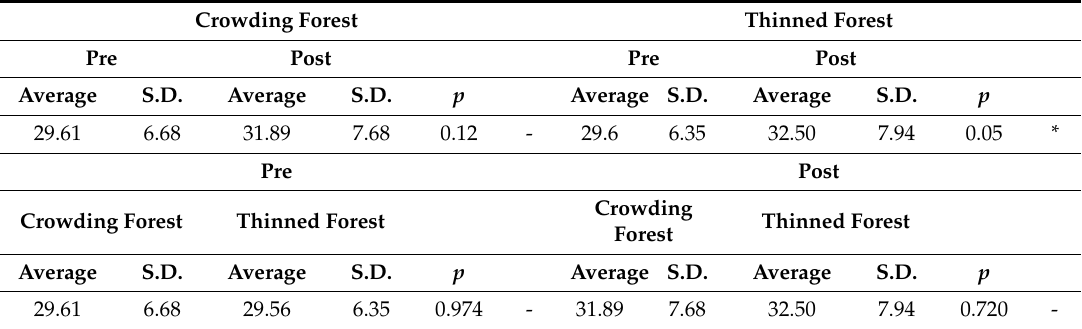
Table 12. Results for the multiple comparison tests before and after exposure using ROS scores. Crowding Forest Thinned Forest Pre Pre